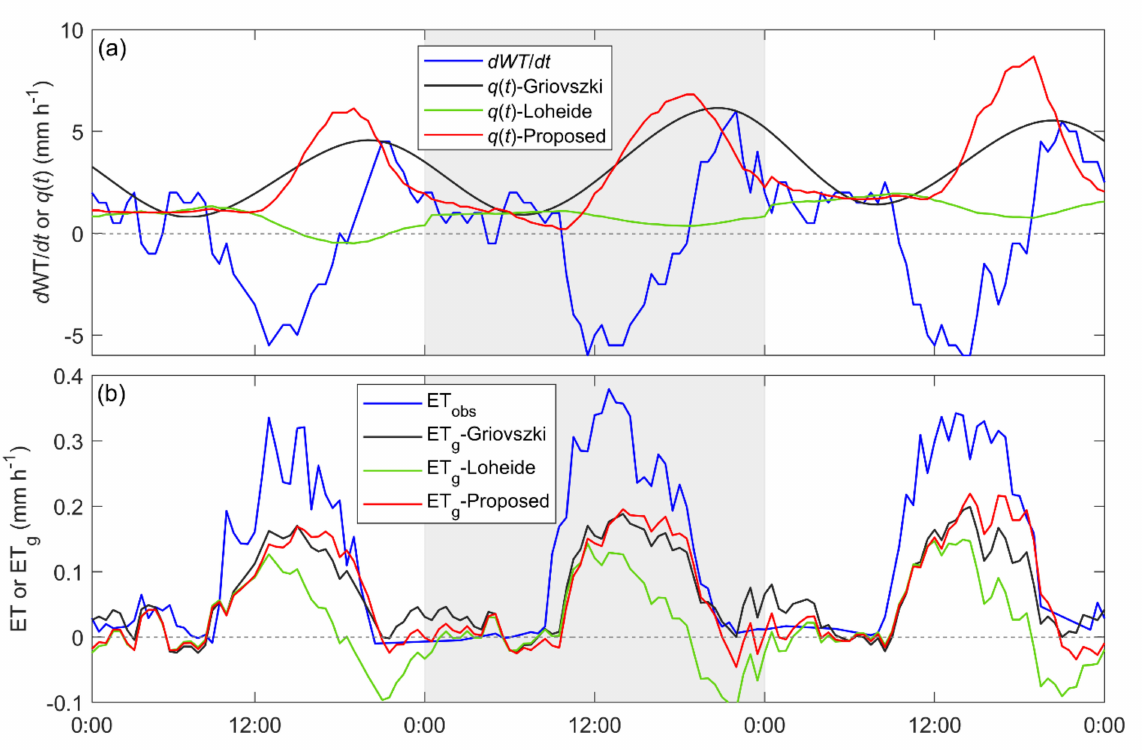
Figure 9. Illustrations of the performances of different sub-daily groundwater evapotranspiration water table level, calculated time-rate of change in measured water table level, and the groundwater recovery rate q ( t ) estimated by the 3 different methods; ( b ) diurnal variations of the measured ET and estimated ETg by the 3 different